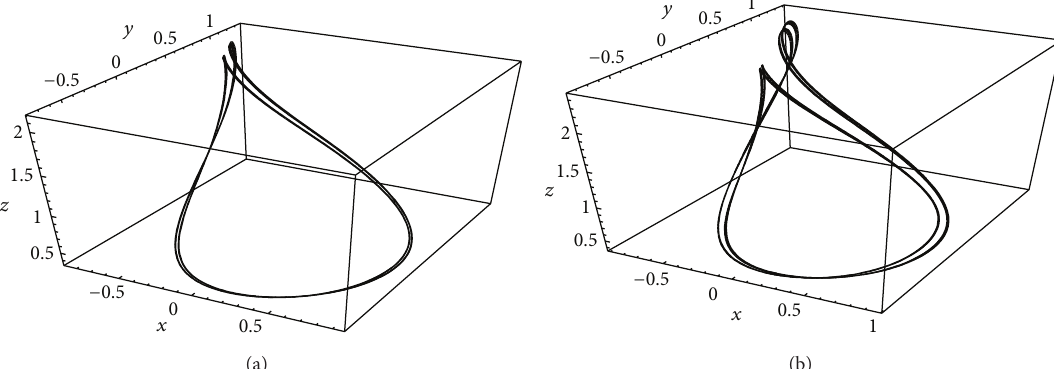
Figure 3: 3D phase portrait refers to the first and second period-doubling